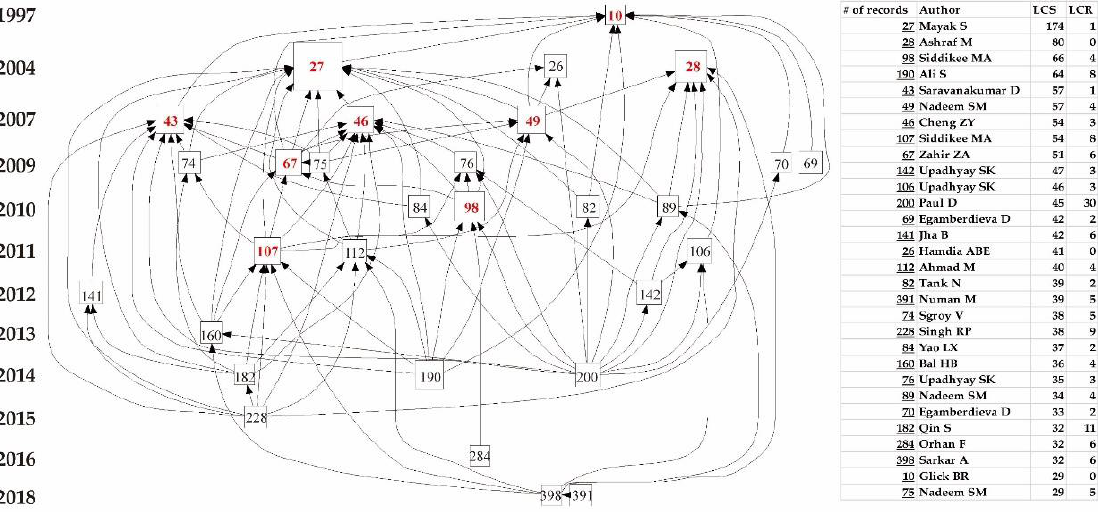
Figure 6. The top 30 publications highly cited by peers in the final database by HistCite Pro. “# “indicates serial